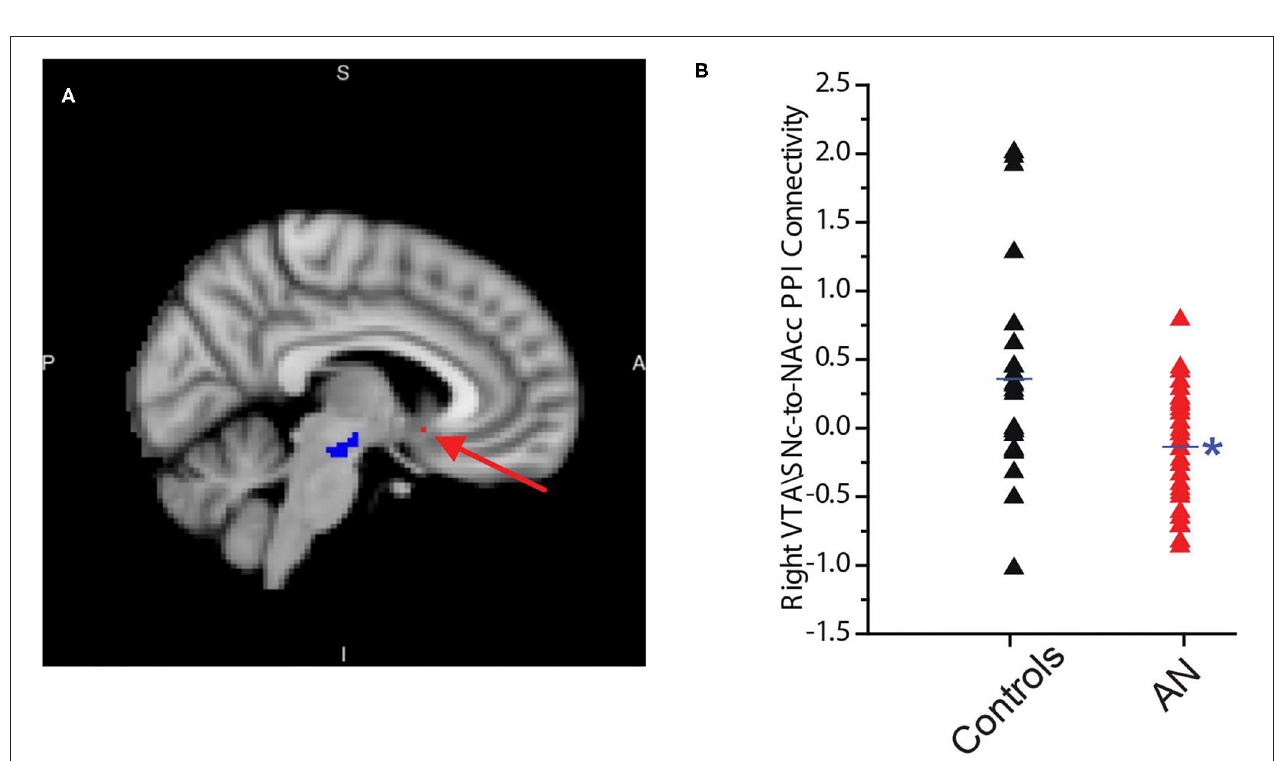
FIGURE 3 | Connectivity of the right ventral tegmental area \ substantia nigra pars compacta (VTA \ SNc) seed (in blue) with a region in right nucleus accumbens (NAcc) (peak coordinates: 8, 10, − 12, in red) is significantly and negatively correlated with duration of reaction time (RT) in controls. No such association exists between the right or left VTA \ SNc seeds and any region in the right or left NAcc in the AN group (A) . The connectivity of the right VTA \ SNc with above-mentioned NAcc area is significantly lower in AN participants compared to controls (B) . The * symbol indicates statistically significant.